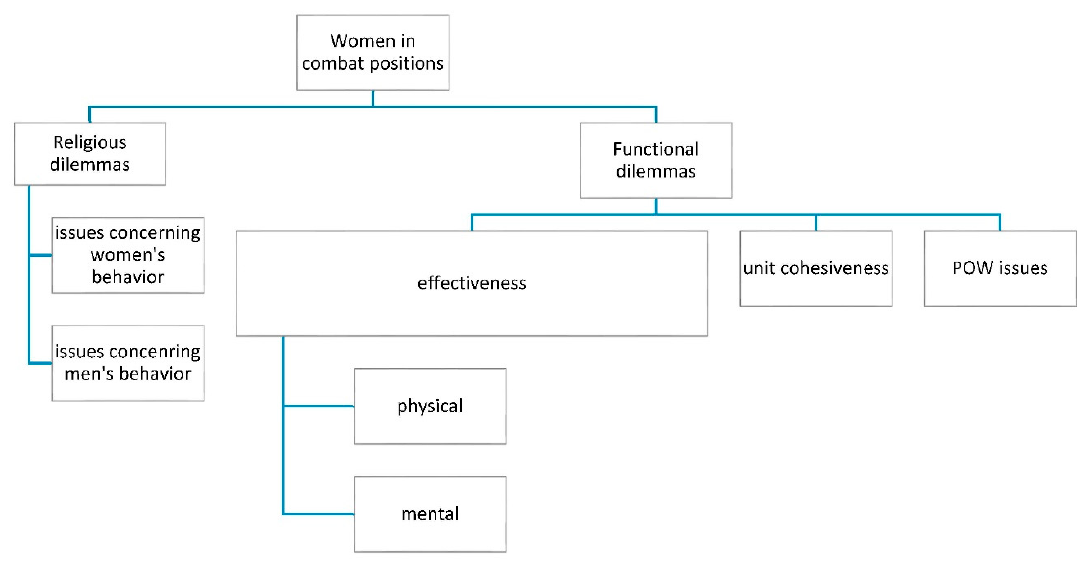
Figure 1. Main categories of arguments.